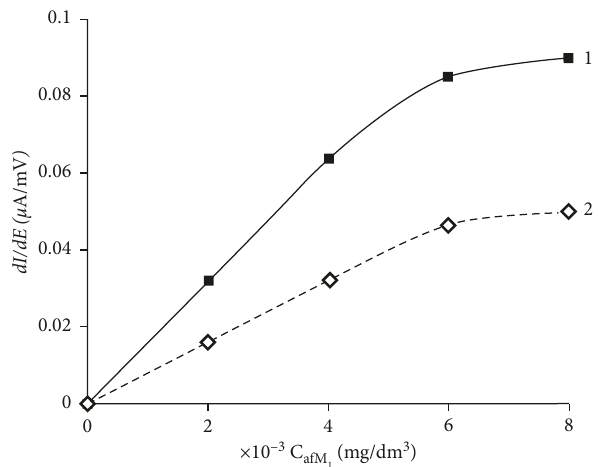
Figure 6: Calibration dependences of aflatoxin N background electrolyte is 0.1 N S 6 O 5 P 7 (NH 4 ) 3 ; F f � 0,0 C ; τ f � 30s; � 0; (2) C � 2 × 10 − 3 mg/dm 3 . (1) C afB 1 afB 1